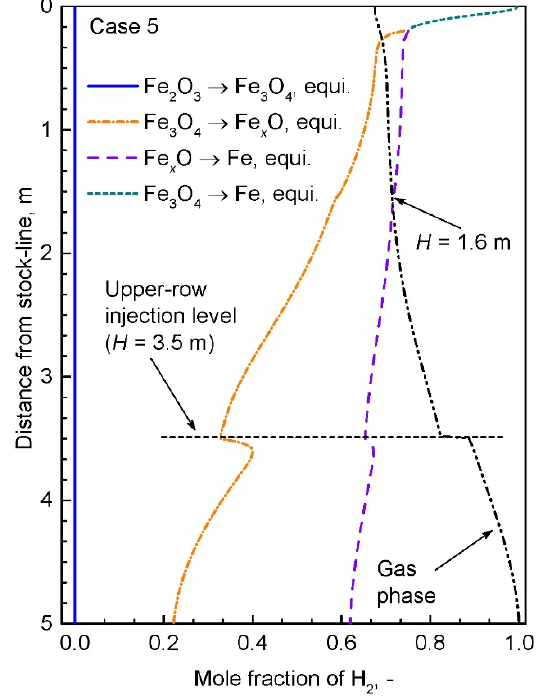
Figure 8. Comparisons between mole fraction of H 2 remaining in the gas phase and the equilibrium values of each reduction step for the scenario of Case 5.